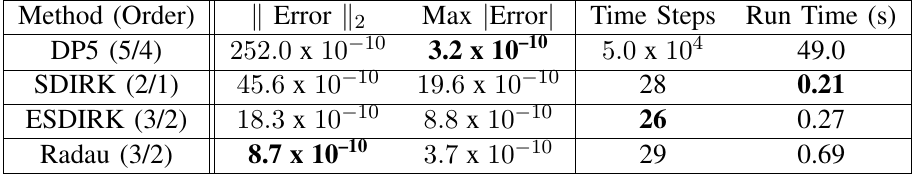
TABLE II: Accuracy and simulation run-time metrics of the DP5 and IRK methods when solving the GABA R model. Boldface font denotes best results of each column. A